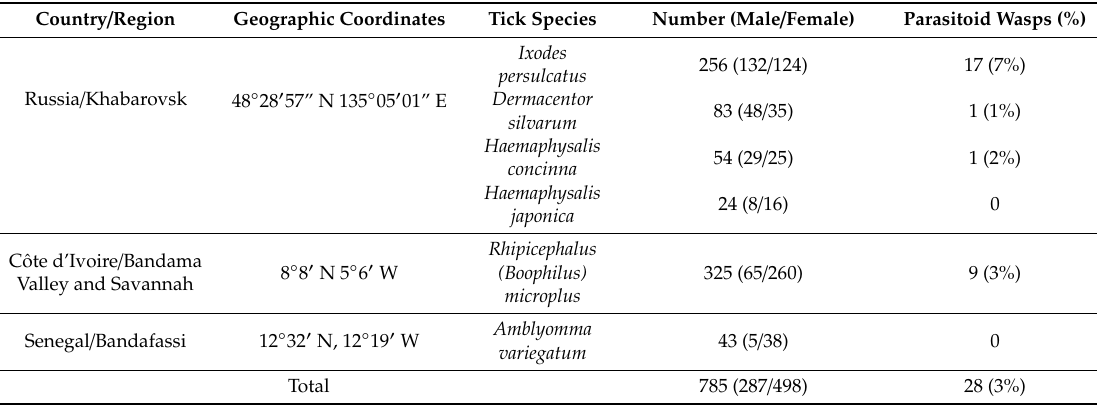
Figure 2. Pictures of hard tick species collected and studied from Western Africa and the Far East. ( A ) Rhipicephalus (Boophilus) microplus , ( B ) Haemaphysalis japonica , ( C ) Haemaphysalis concinna , ( D ) Amblyomma variegatum , ( E ) Dermacentor silvarum, and ( F ) Ixodes persulcatus . Table 1. Ticks species, location, and parasitoid wasps’ infection.